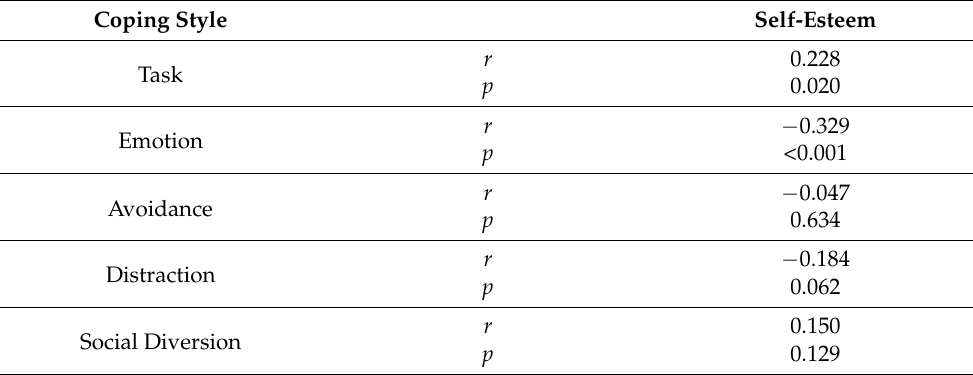
Table 4. Relationship of self-esteem and coping styles; r —Pearson’s correlation coefficient. p — significance